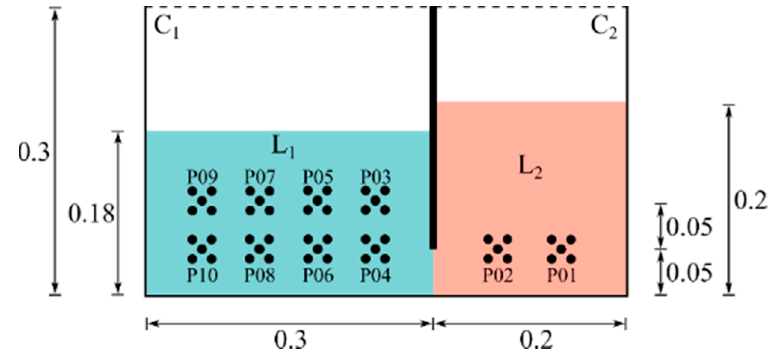
Figure 3. Distribution of the numerical probe sets.